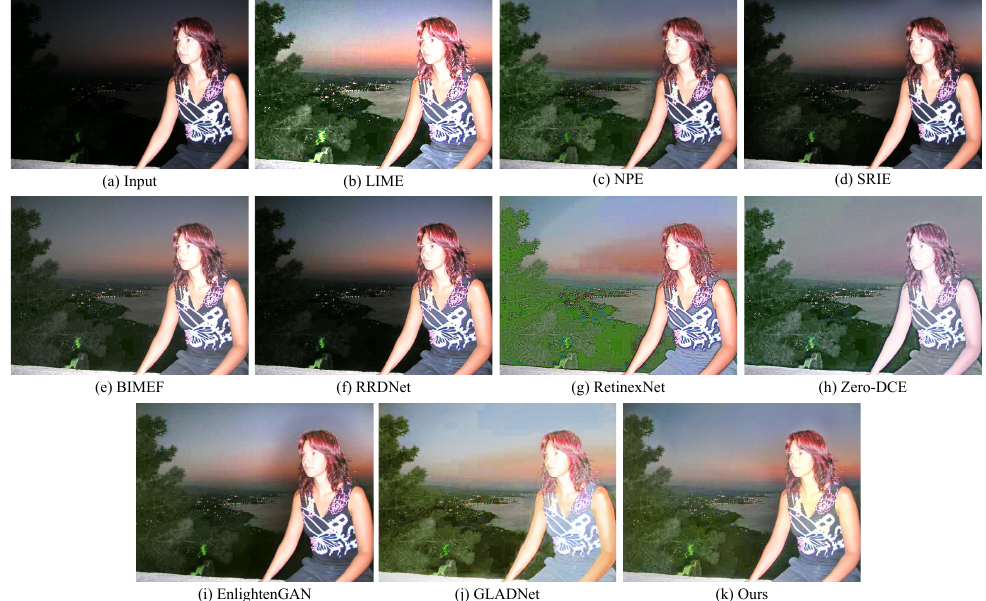
Figure 9. Visual comparisons of different methods on a real image from VV